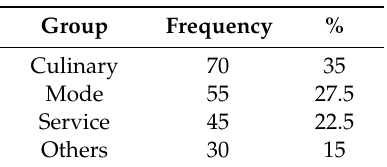
Table 1. Descriptive